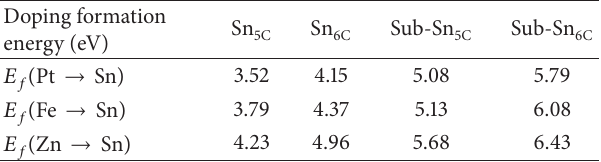
Table 1: The doping formation energy of Sn 47 MO 96 . Doping